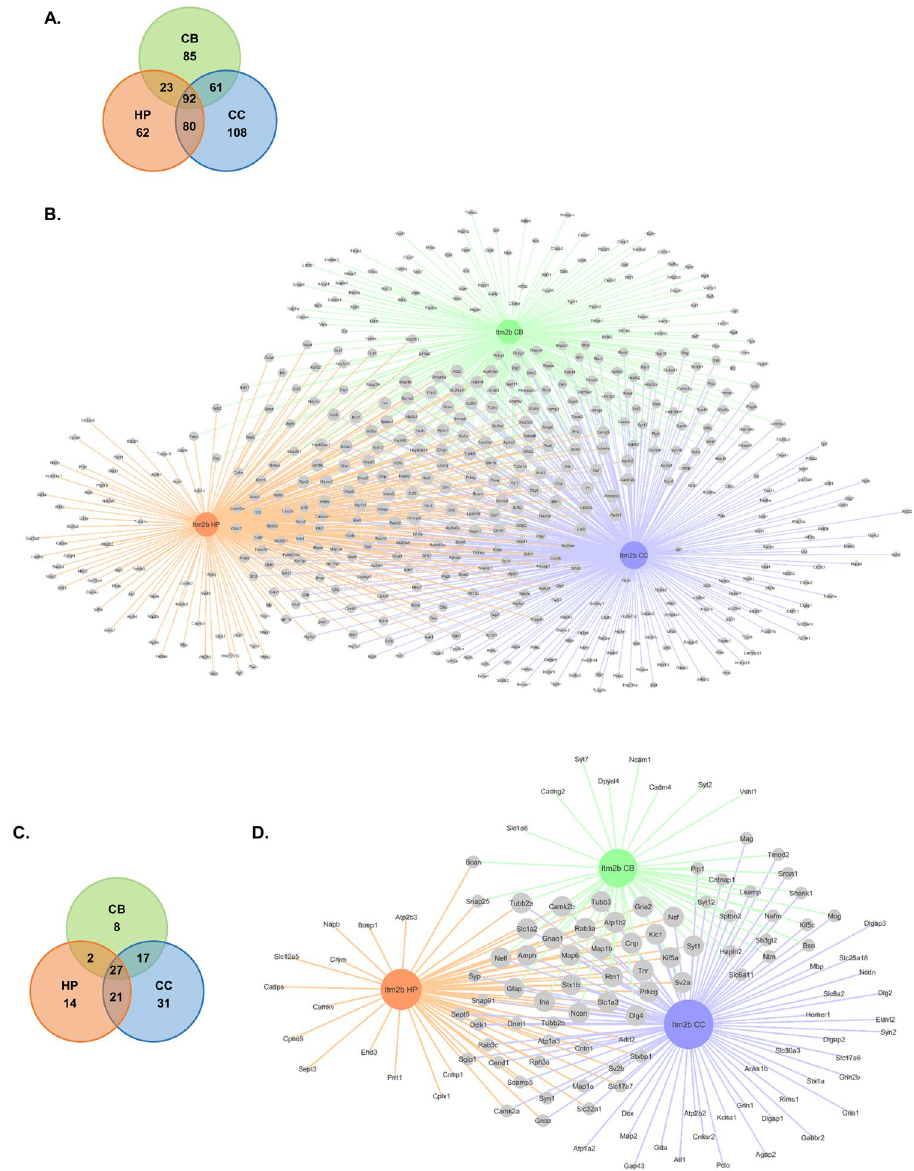
Figure 4. Brain region specific protein interactions in the BRI2 interactome. ( A , B ) Brain region specific protein interactions revealed in the identified BRI2 interactome. ( A ) Venn diagram comparison of the brain region (cerebral cortex, hippocampus, and cerebellum) specific BRI2 protein interactions identified in this study. ( B ) BRI2 interactome identified in this study. Node size according to the degree in the network. Edge color represents the source of interaction: blue edges correspond to the BRI2 interactions identified in the cerebral cortex, orange edges correspond to the BRI2 interactions identified in the hippocampus, and green edges correspond to the BRI2 interactions identified in the cerebellum. ( C , D ) Brain region specific protein interactions revealed in the identified BRI2 ES interactome. ( C ) Venn diagram comparison of the brain region (cerebral cortex, hippocampus, and cerebellum) specific BRI2 protein interactions identified in this study, highly enriched or specific for the brain. ( D ) BRI2 ES interactome identified in this study. Node size according to the degree in the network. Edge color represents the source of interaction: blue edges correspond to the BRI2 interactions identified in the cerebral cortex, orange edges correspond to the BRI2 interactions identified in the hippocampus, and green edges correspond to the BRI2 interactions identified in the